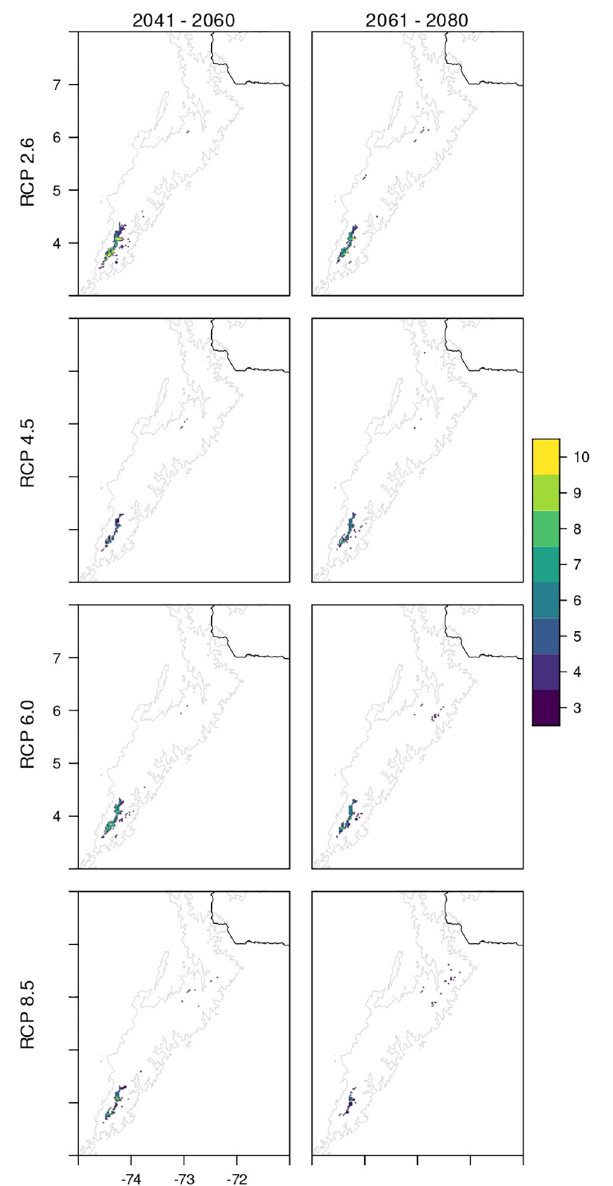
FIGURE 3 | Projection of the Habitat Suitability Model (HMS) of P. quadrijuga to future climate conditions derived from twelve general circulation models (GCMs) for the periods (2041–2060 and 2061–2080) under four Representative Concentration Pathway (26, 45, 60, and 85). The discrete color scale represents the number of different projections derived from the 12GCMs that support the presence of the species for future climate scenarios.